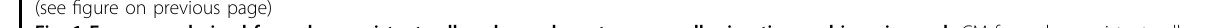
Fig. 1 Exosomes derived from drug-resistant cells enhance breast cancer cell migration and invasion. a , b CM from drug-resistant cells signi fi cantly enhanced the migratory ability of human breast cancer MDA-MB-468 cells and T47D cells compared with CM from parental cells and fresh medium control as measured by wound healing assay. All experiments were repeated at least three times. **** P < 0.0001. Scale bars: 200 μ m. c Transmission electron microscopic image of exosomes derived from drug-resistant cells and its parental cells. Scale bars: 200 nm. d Nanoparticle tracking analysis (NTA) of exosomes derived from drug-resistant cells and its parental cells. e Equal amounts of protein (100 μ g) from drug-resistant cells and its parental cells and exosomes were analyzed by Western blotting. Alix, TSG101, and CD81 were used as the positive control of exosomes, and Calnexin was used as the negative control of exosomes. f, g Exosomes derived from drug-resistant cells (DR-Exos) signi fi cantly increased the migration and invasion ability of two breast cancer cells compared with exosomes derived from drug-sensitive cells (DS-Exos). For cell migration assay, 5 × 10 4 cells suspended in 200 μ L of serum-free medium were loaded onto the upper chambers. Six hundred microliters of medium with 10% FBS was added into the lower chamber. For cell invasion assay, 1 × 10 5 cells suspended in 200 μ L of serum-free medium were loaded onto the upper chambers coated with Matrigel. The incubation time was 24 h. The statistical results were summarized in the right panel. Data were expressed as mean ± SD. All experiments were repeated at least three times. **** P < 0.0001 and ns P > 0.05 indicate no statistical signi fi cance. Scale bars: 200 μ m. h Knockdown of Rab27a reduced the amounts of exosomes derived from MDA-MB-468/EPR cells. i Knockdown of Rab27a suppressed the migration- promoting effect of CM derived from drug-resistant cells. All experiments were repeated at least three times. **** P < 0.0001. Scale bars: 200 μ